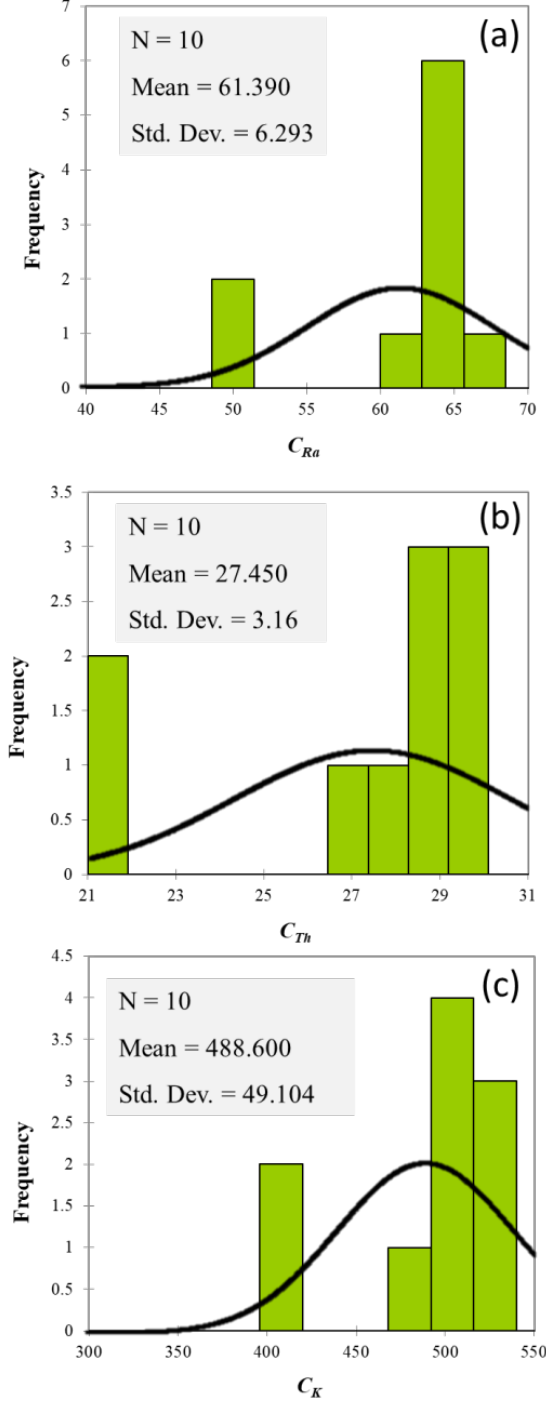
Figure 2. The frequency distributions of 226 Ra ( a ), 232 Th ( b ), and 40 K ( c ) specific activities. The highest values of 226 Ra (67.5 ± 7.5 Bq Kg −1 d.w.), 232 Th (30.0 ± 4.3 Bq Kg −1 d.w.), and